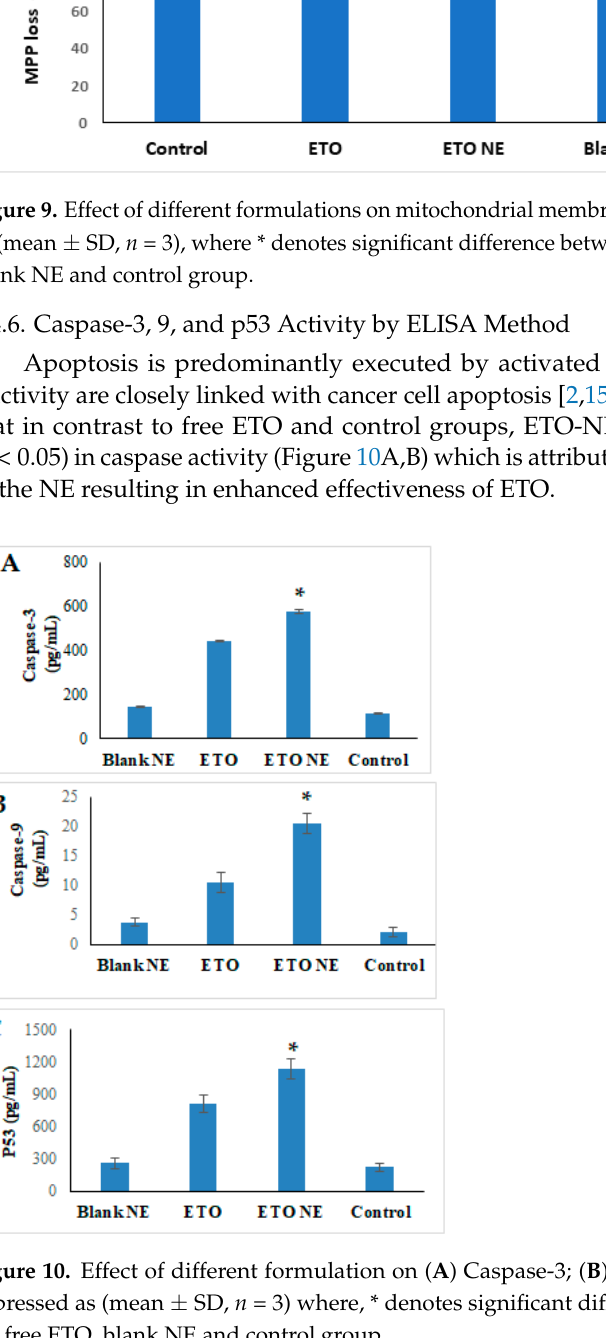
13 of 18 Figure 8. Flow cytometric analysis of ETO NE, free ETO, blank NE, and control group on cell cycle distribution in A549 cells. Data are expressed as (mean ± SD, n = 3), where * denotes significant difference between ETO NE ( p < 0.05) vs. free ETO, blank NE and control group. In an anticancer therapeutic regime, targeting cell cycle progression could be a po- tential approach [2,15,17]. The outcome of the present study demonstrates that both ETO and ETO-NE effectively arrested the cell cycle at G2/M and G1/S transitions, suggestive of substantial DNA damage leading to cell death [2]. Furthermore, the reduced percentage of cells in the S-phase as a result of treatment with ETO-NE (26.28 ± 2.19%) compared to either free ETO (31.1 ± 4.33%) or control (39.68 ± 2.80%) revealed potential DNA damage through NE during the G1 phase [2]. 3.4.5. Mitochondrial Membrane Potential Activity